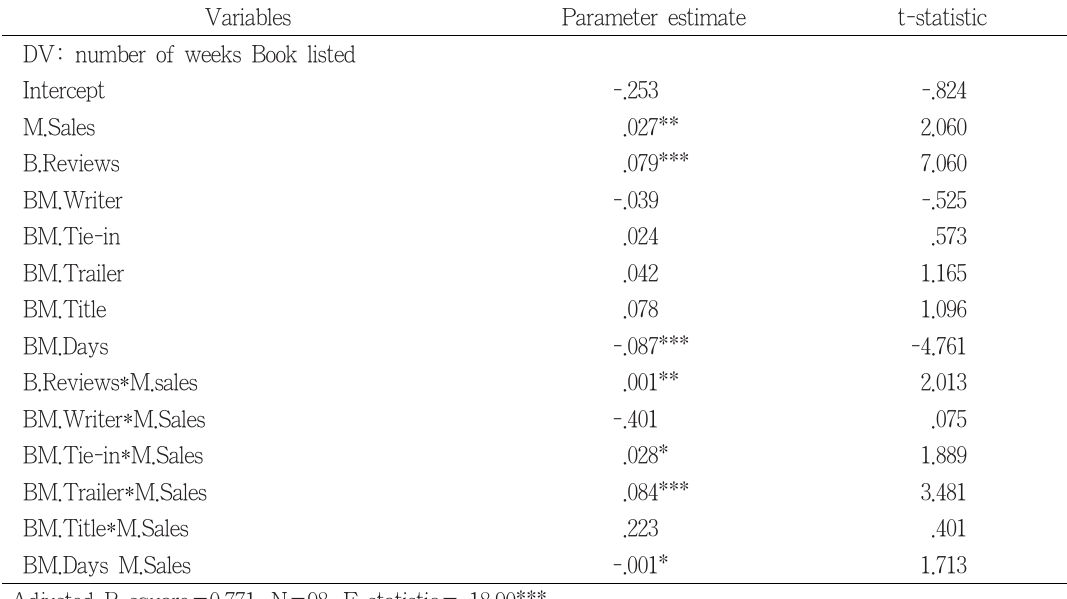
<Table 4> Estimates of Linear regression model: Cross-sectional